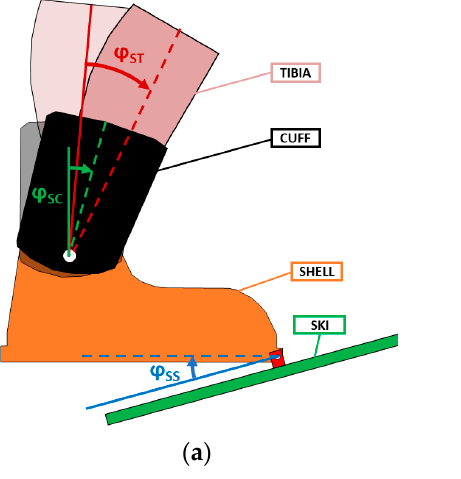
Figure 2. Ski touring boot kinematic sensors: ( a ) kinematic chain of the boot, zero is set with the unloaded ski boot (solid lines); ( b ) sensor application to the medial and lateral side of the boot.